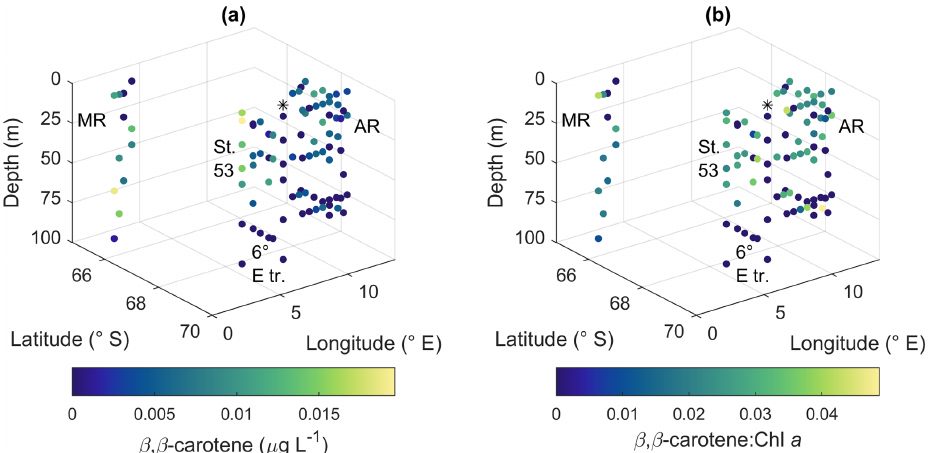
Figure A13. (a) β , β -carotene concentration and (b) ratio of β , β -carotene to Chl a . MR: Maud Rise, St. 53: station 53, AR: Astrid Ridge, 6 ◦ E tr.: 6 ◦ E transect. Station 54 is marked with a black asterisk.